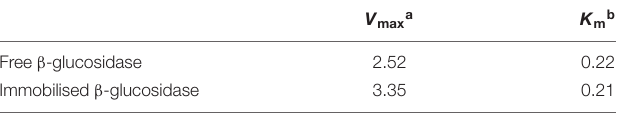
TABLE 1 | Apparent kinetic constants of native and immobilised β -glucosidase. V maxa K mb